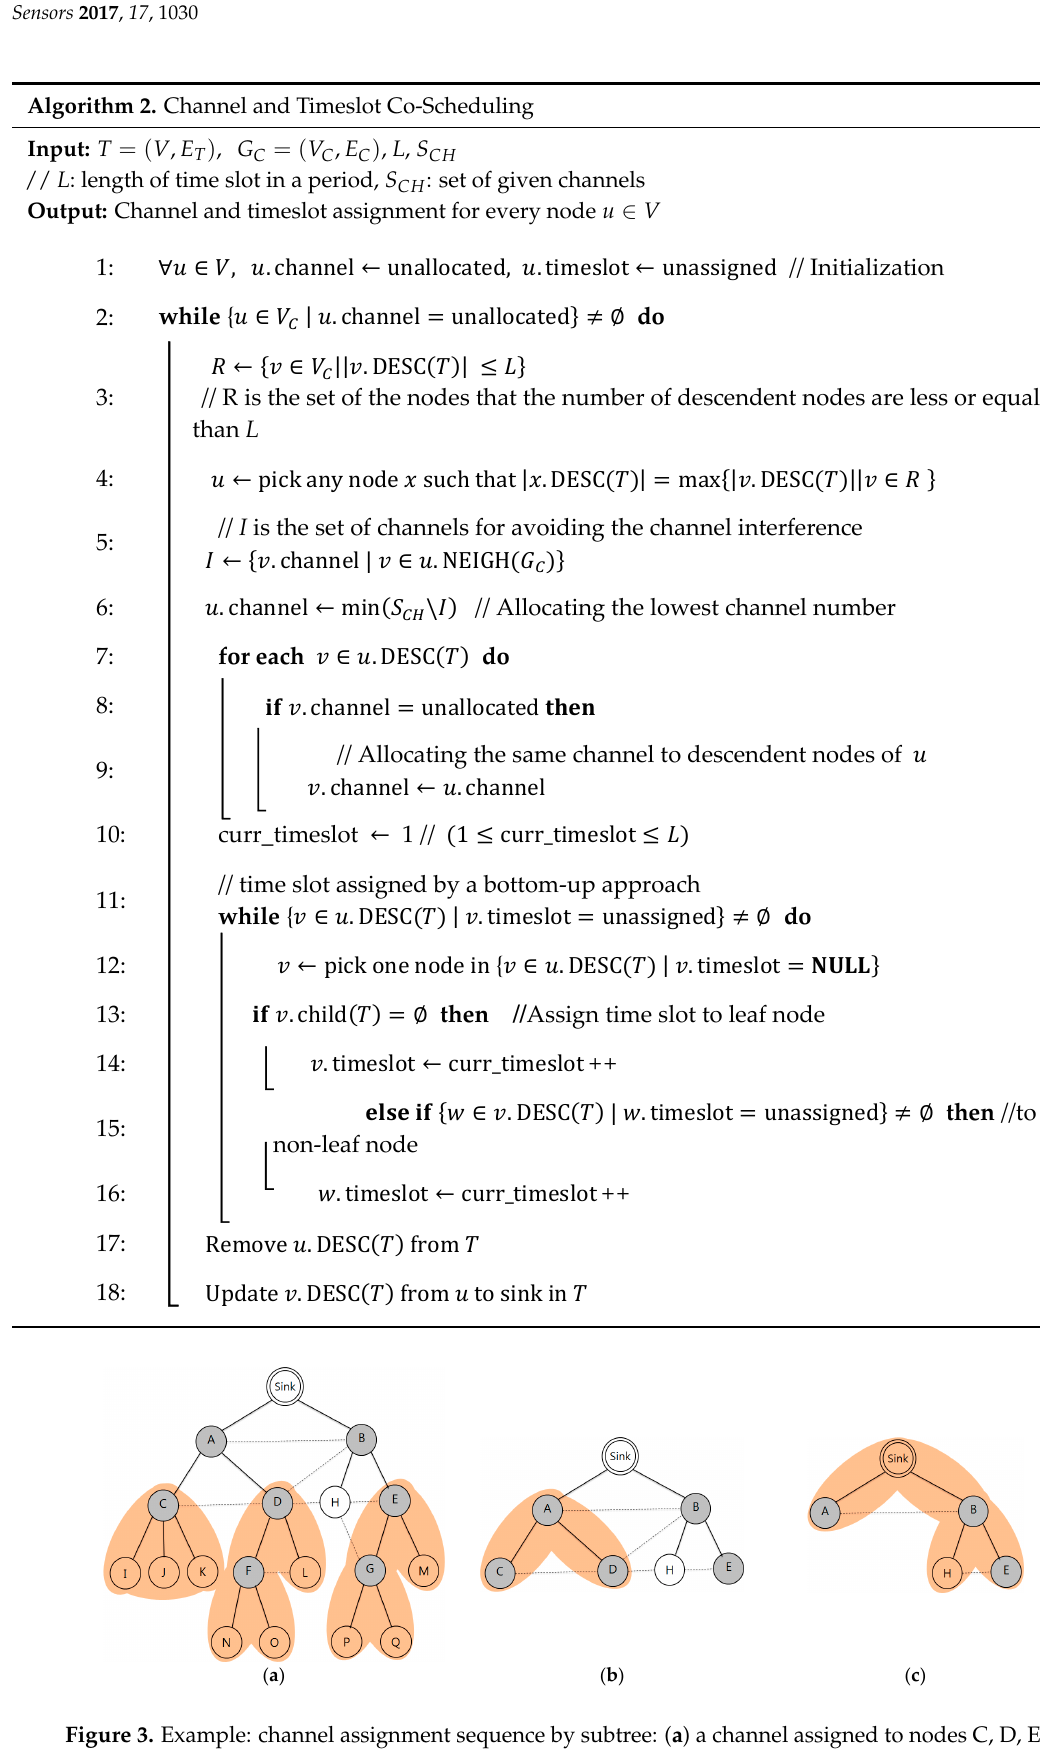
( c ) Figure 4. Example: channel and time slot scheduling between the LDF and the proposed scheme: ( a ) channel and time slot scheduling by the LDF; ( b ) channel and time slot scheduling table of Figure 4a; and ( c ) channel and time slot scheduling table of Figure 2c.